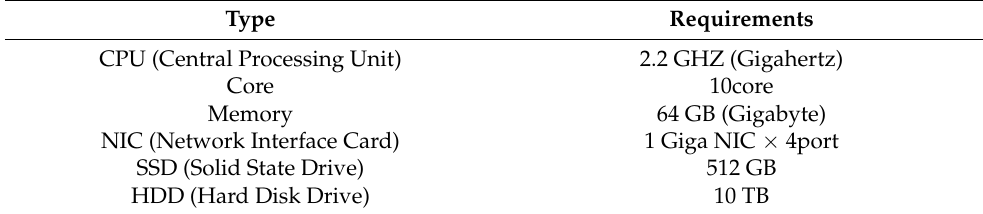
Table 6. Hardware configuration of the test